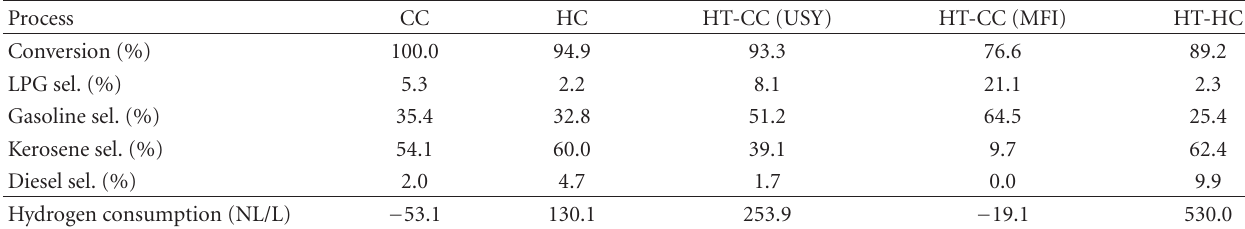
Table 4: Comparison of the obtained fuel fraction from various